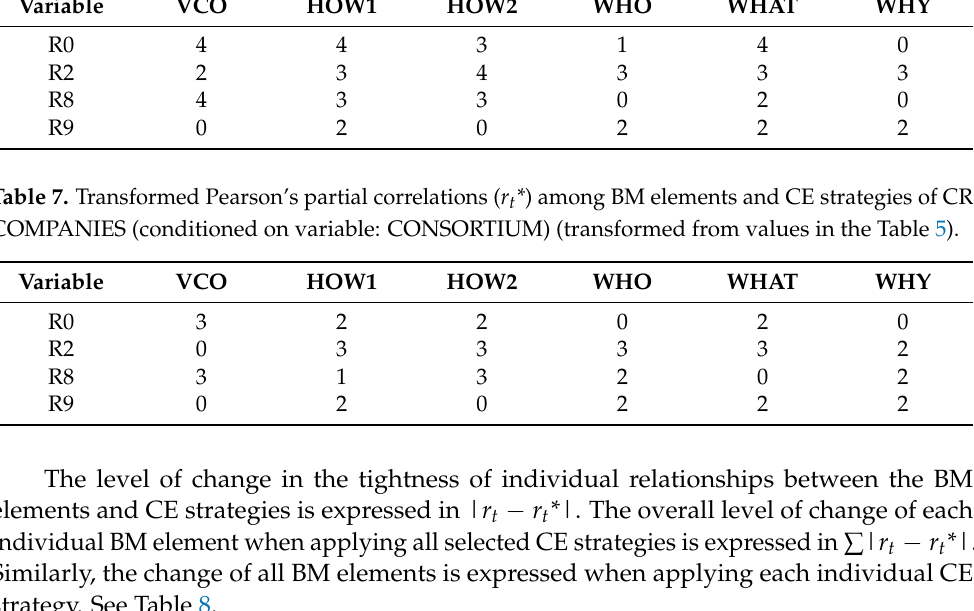
Table 6. Transformed Pearson’s correlations ( r t ) among BM elements and CE strategies of CR COMPANIES (transformed from values in the Table 4). Variable VCO HOW1 HOW2 WHO WHAT WHY